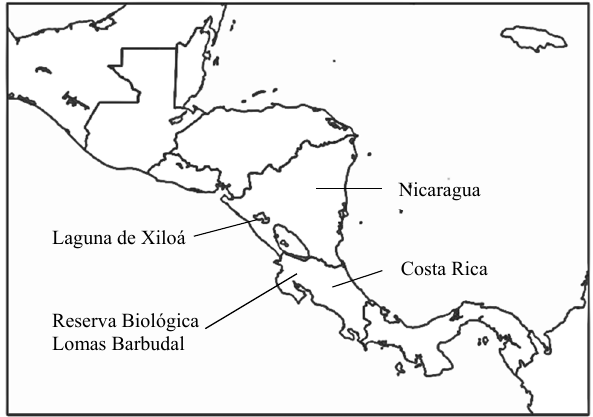
Figure 1. Map of Central America indicating the location of Lomas Barbudal Biological Reserve and Laguna de Xiloá.